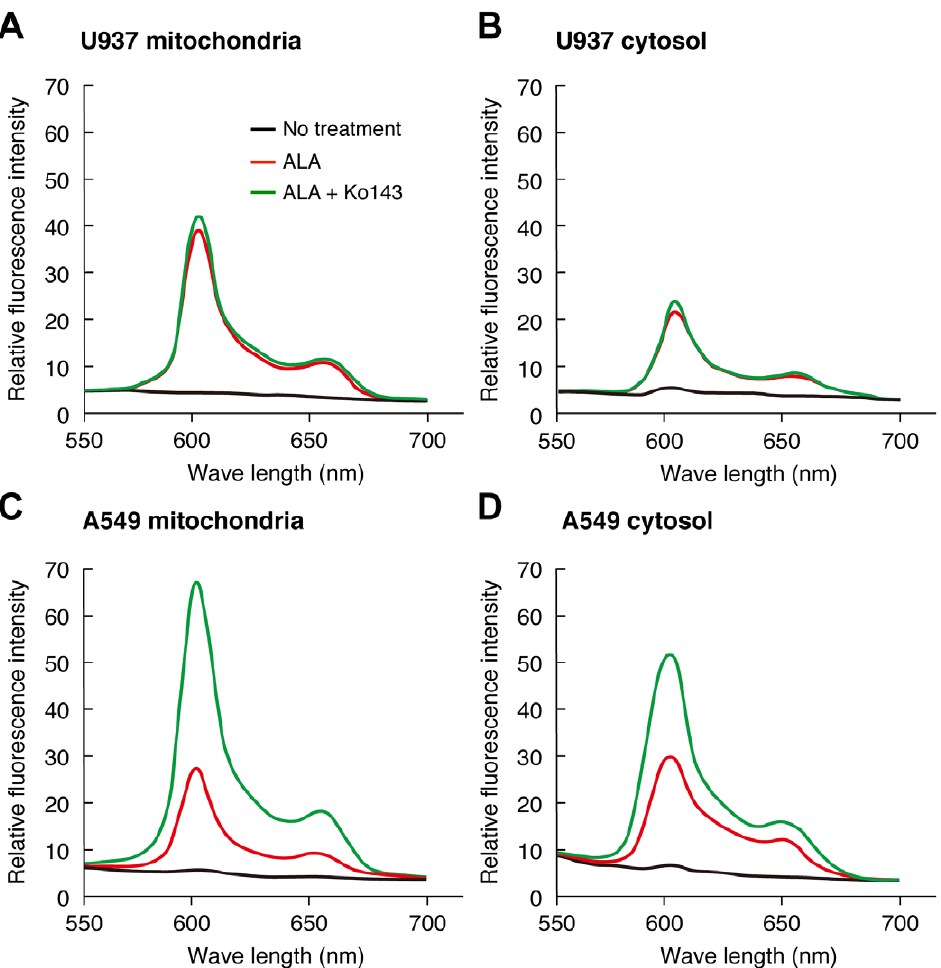
Figure 4. Regulation of the intra-mitochondrial content of ALA-mediated PpIX by Ko143, a specific inhibitor of ABCG2. U937 cells and A549 cells were incubated for 3 h with 1 mM ALA in complete medium in the presence or absence of 1 m M Ko143. After incubation, cells were washed with ALA-free medium and mitochondrial and cytosolic fractions were isolated as described in Materials and Methods. The fluorescence spectrum of each fraction was analyzed by a fluorophotometer. A representative histogram of three independent experiments is shown. The levels of PpIX were shown by black line (No treatment), red line (ALA without Ko143), green line (ALA with Ko143), respectively.